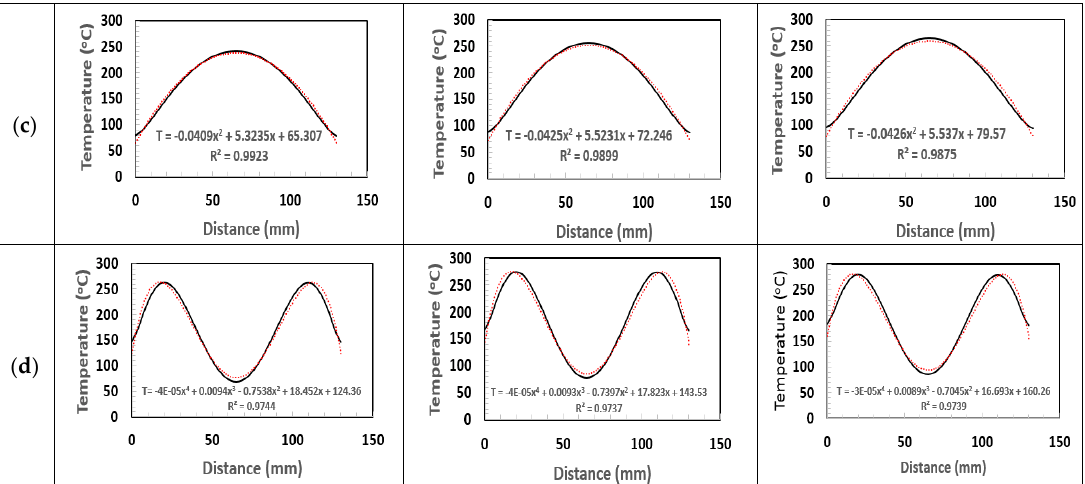
Figure 9. Curve fitting of temperature data obtained by finite element analysis. ( a ) Uniform, ( b ) Linear, ( c ) Quadratic, ( d ) Quartic.